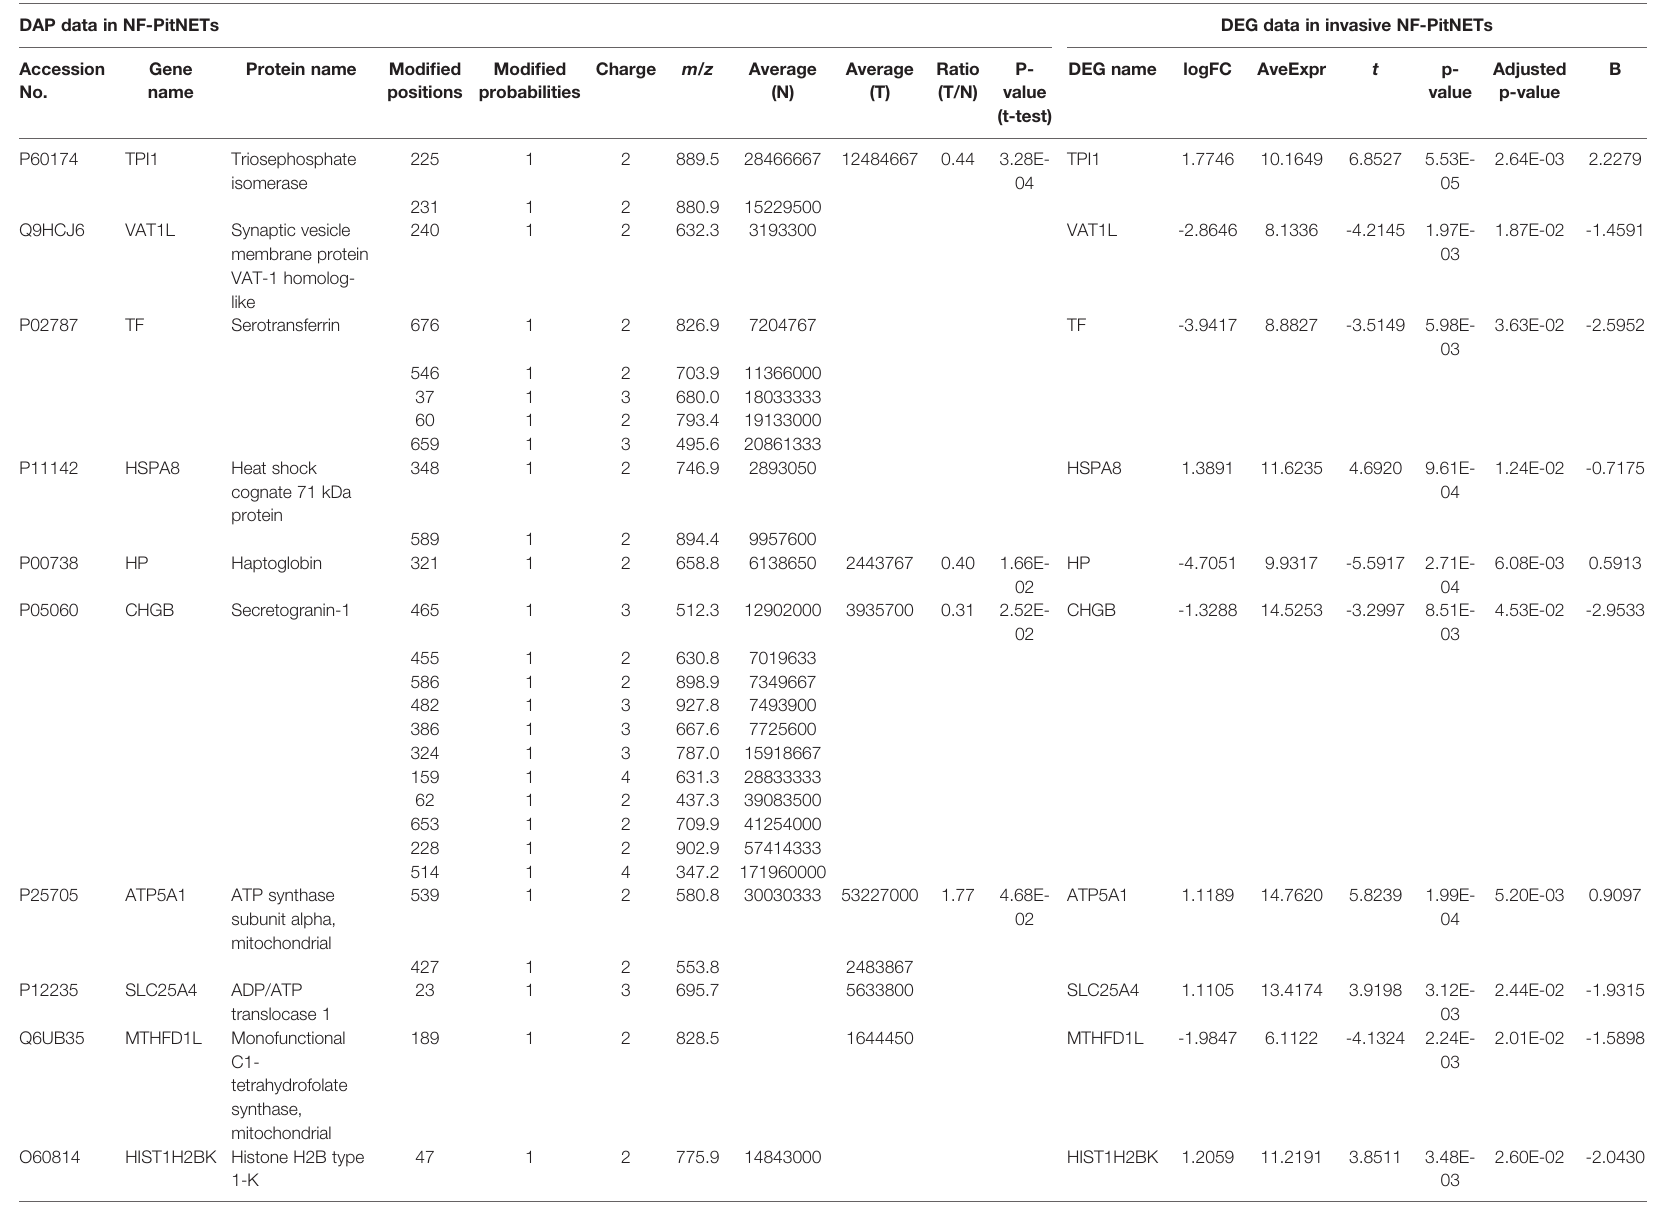
TABLE 2 | The overlapped molecules between differentially acetylated protein (DAP) data and invasive DEG data in NF-PitNETs. LogFC = log2(Fold change). DAP data in NF-PitNETs DEG data in invasive NF-PitNETs Accession